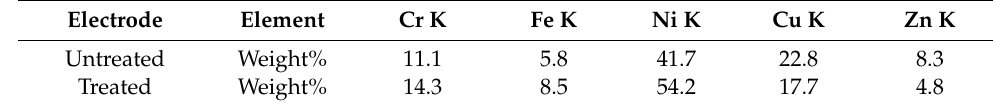
Table 7. EDS results for the untreated and treated electrodes.